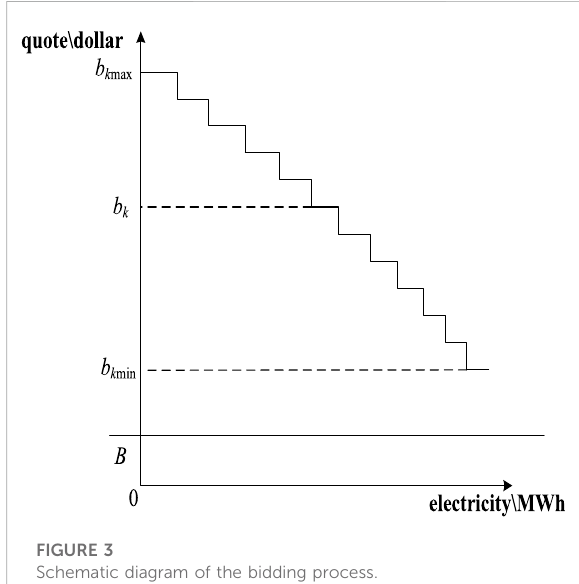
FIGURE 3 Schematic diagram of the bidding